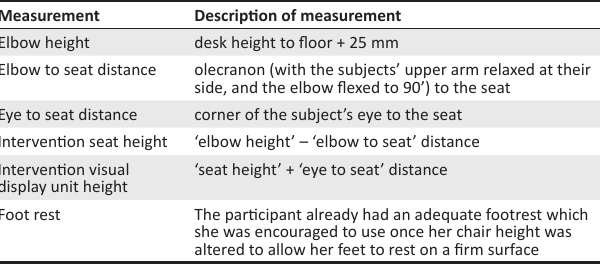
TABLE 1: Recommended workstation measurements.